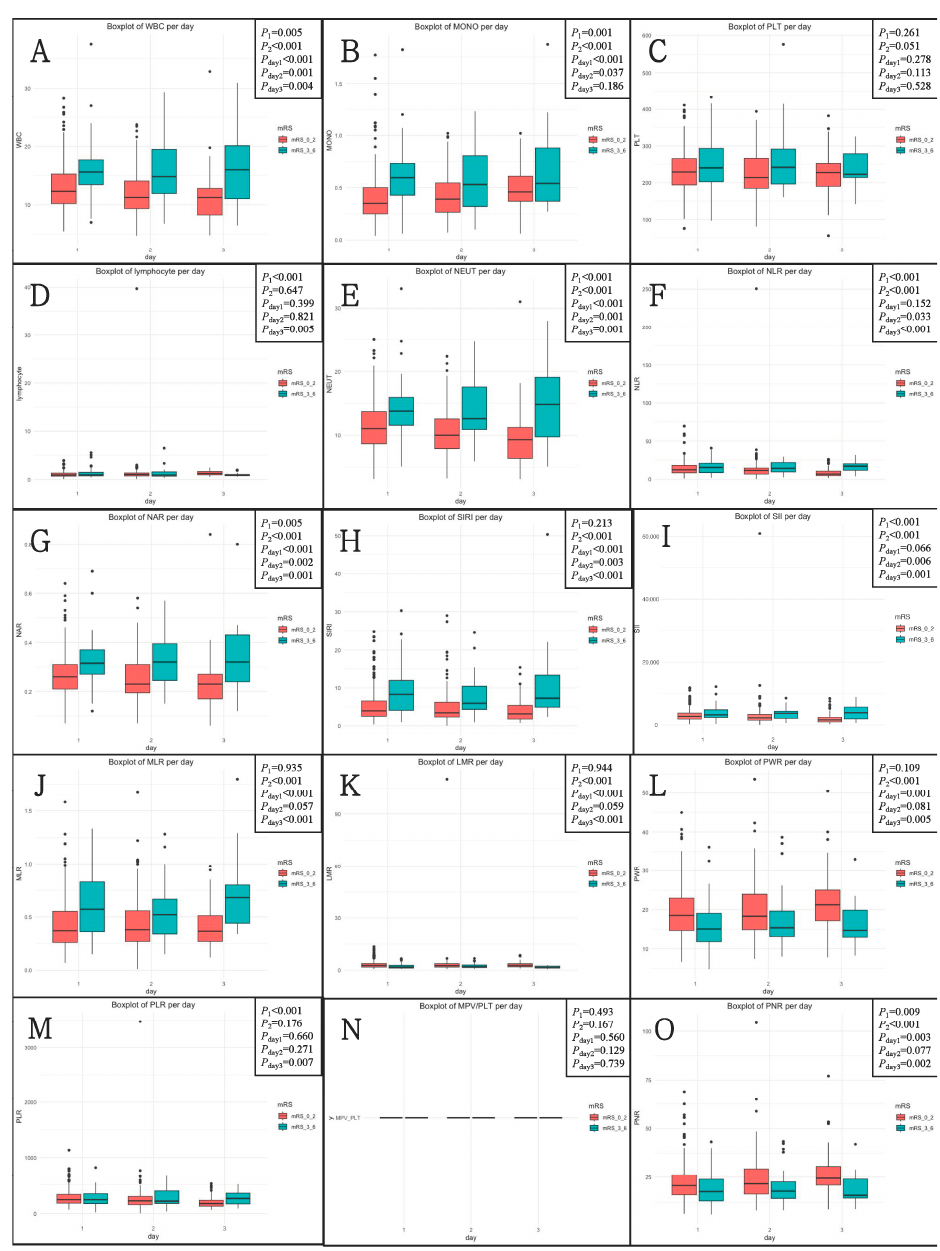
Figure 1. The levels of inflammatory biomarkers according to three blood sample drawn timings (Day 1, Day 2, and Day 3) across 90-day functional outcomes. ( A ) WBC; (B ) MONO; ( C ) PLT; ( D )